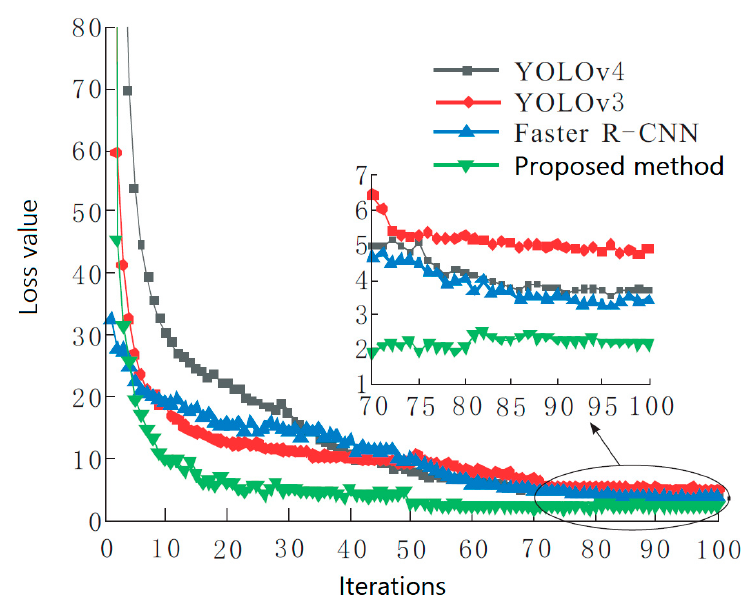
Figure 7. Convergence performance comparison.